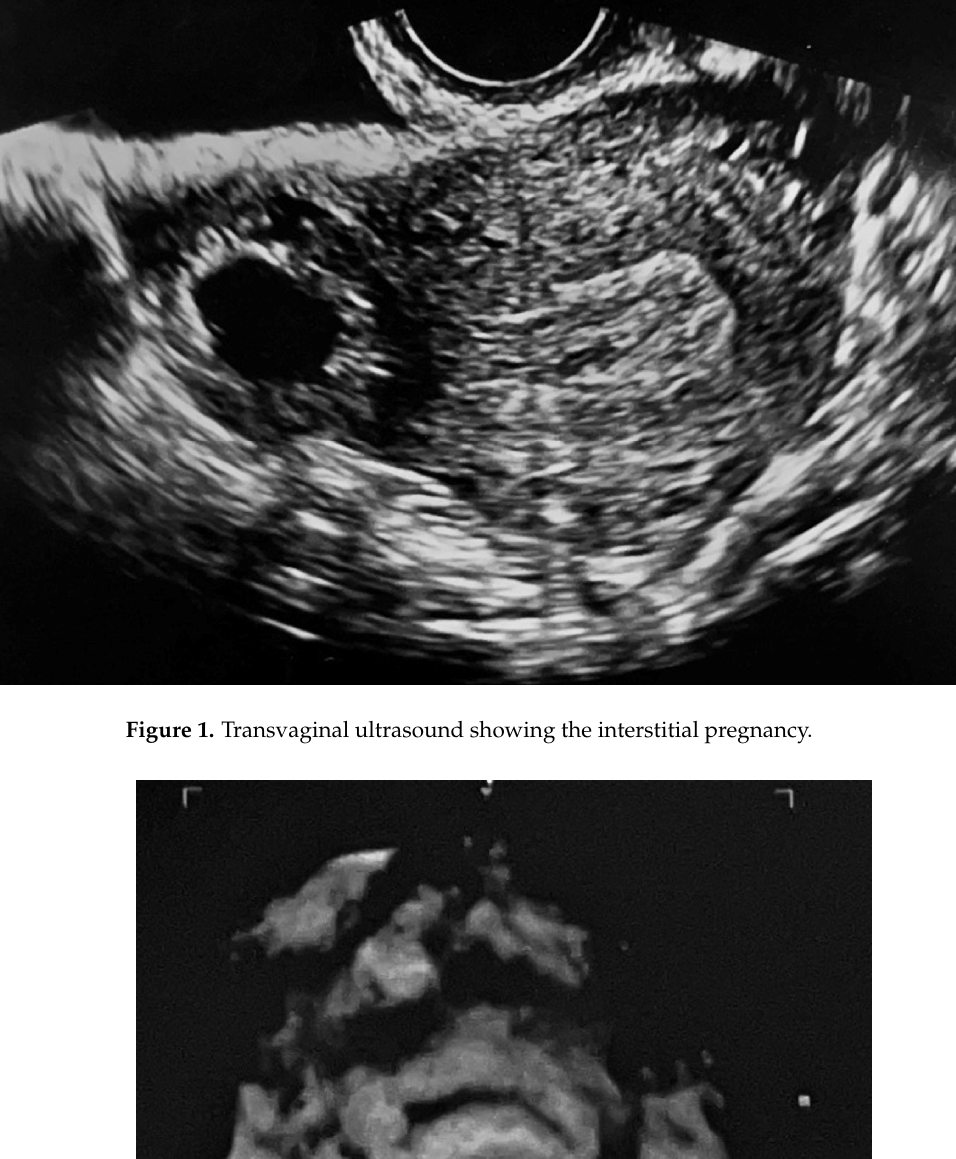
Figure 2. 3D transvaginal ultrasound showing the interstitial pregnancy.